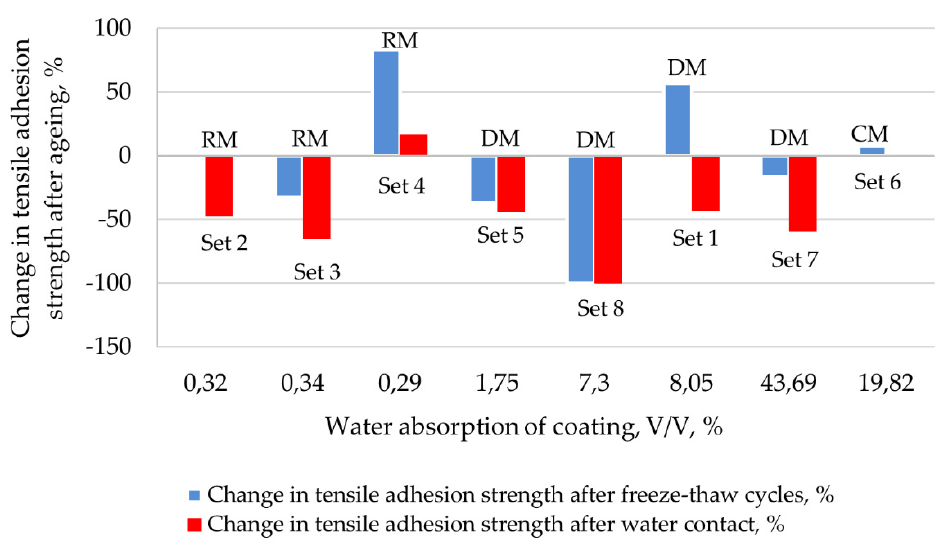
Figure 8. Graphic presentation of the change in the test set tensile adhesion strength after freeze/thaw cycles and after water contact, in reference to the water absorption of coatings.